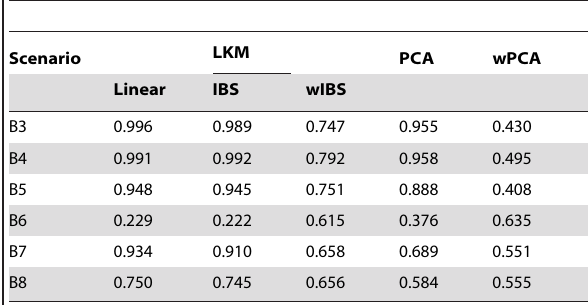
Table 4. Test of Power for LKM, PCA and wPCA in Scenarios